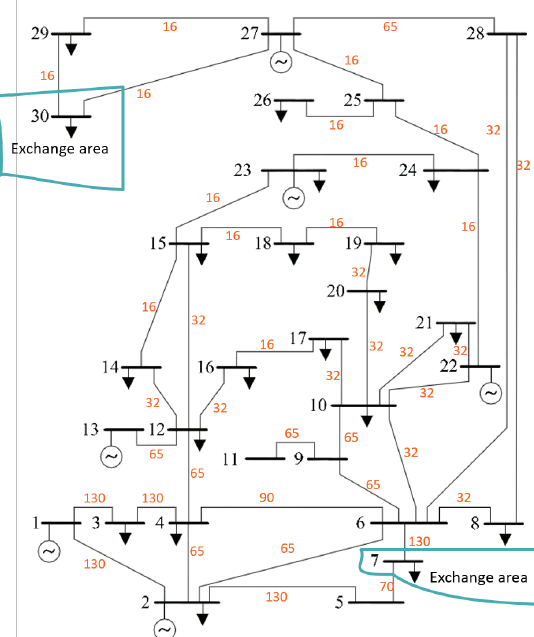
Figure 2. Single line diagram of the test system used, indicating bus numbers (black) and rated line capacities in MW